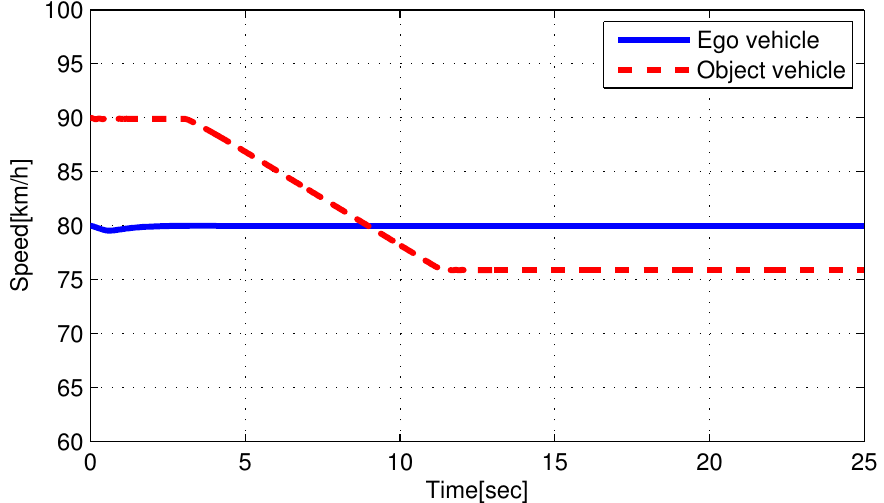
Figure 7. Velocities of ego and object vehicle of case